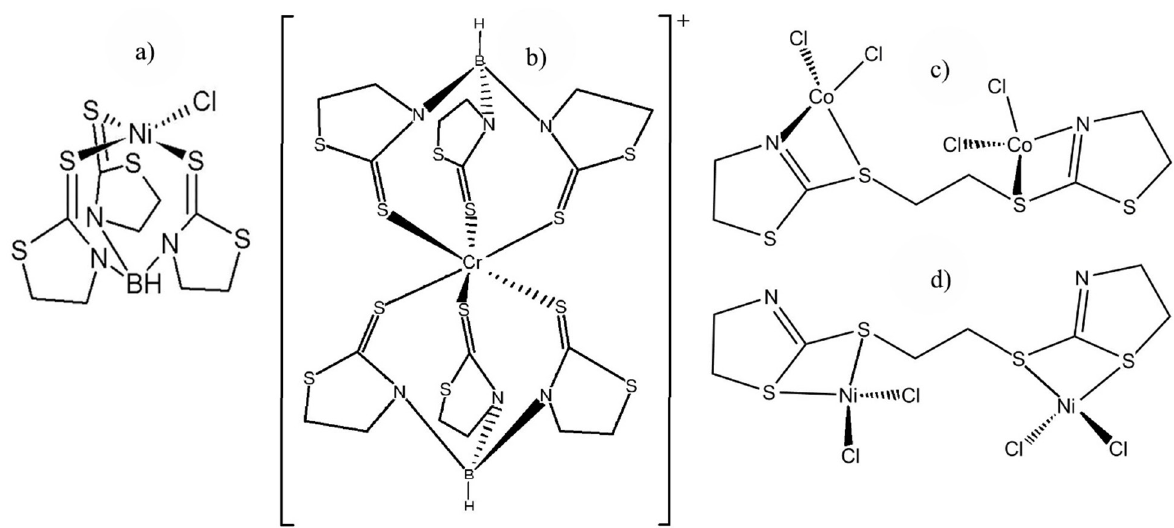
Figure 2 - Structures proposed for complexes 1 and 2 ( a and b ) formed from the hidrotris(2-mercaptothiazolyl) borate ligand and complexes 3 and 4 ( c and d ) formed from